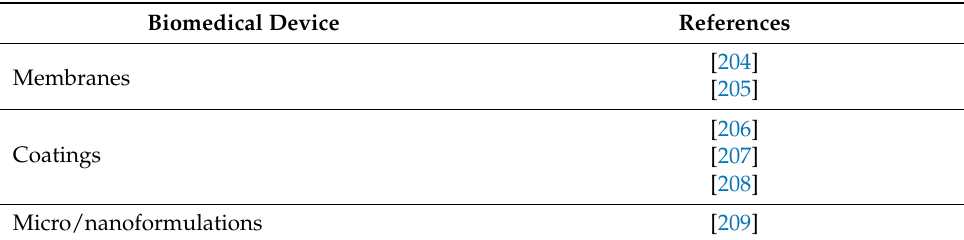
Table 4. Ulvan Based Biomedical